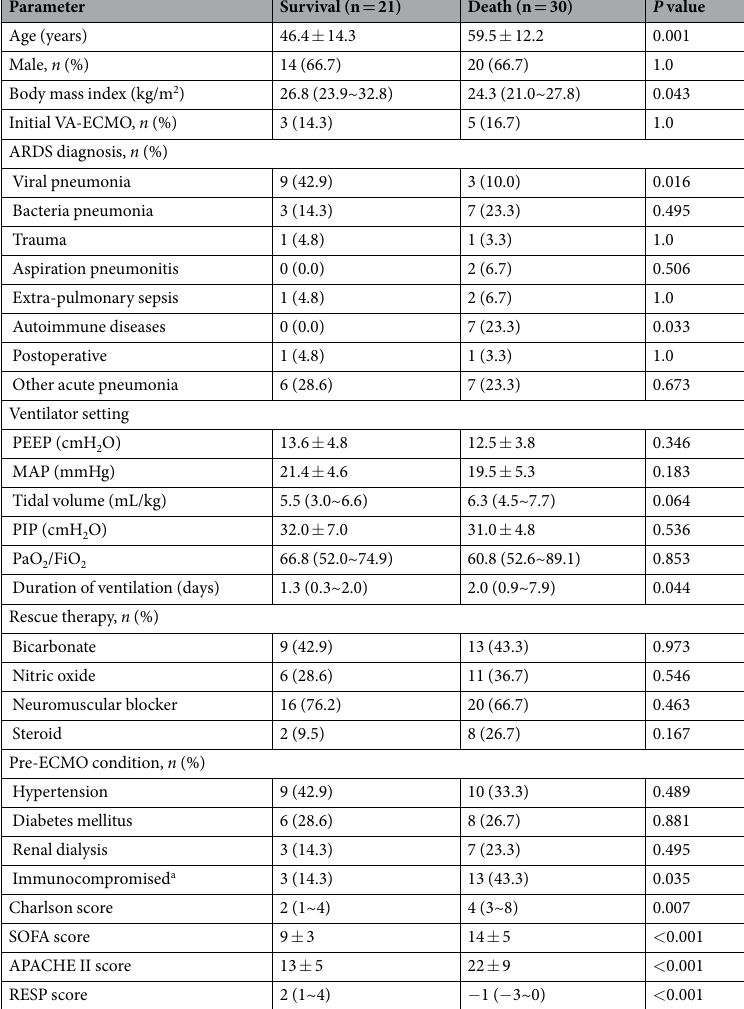
Table 1. Comparison of baseline characteristics before implementation with extracorporeal membrane oxygenation of the study subjects according to their survival status at ICU discharge. Continuous data values are shown as medians with inter-quartile ranges for variables with non-normally distributed characteristic, or means ± standard deviation for variables following normal distribution pattern. The number of patients with frequency (percentage, %) is shown for categorical data. The listed P values of statistical tests were calculated using Mann–Whitney U or Student’s t test for continuous data and the χ 2 or Fisher’s exact test for categorical data. a Immunocompromised is defined as hematological malignancies, solid tumor, solid organ transplantation and/or cirrhosis. VA-ECMO, venous-arterial extracorporeal membrane oxygenation; ARDS, acute respiratory distress syndrome; PEEP, positive end-expiratory pressure; MAP, mean airway pressure; PIP, peak inspiratory pressure; PaO 2 , partial pressure of oxygen; FiO 2 , fraction of inspired oxygen; SOFA, sequential organ failure assessment; APACHE, acute physiology and chronic health evaluation; RESP, respiratory extracorporeal membrane oxygenation survival